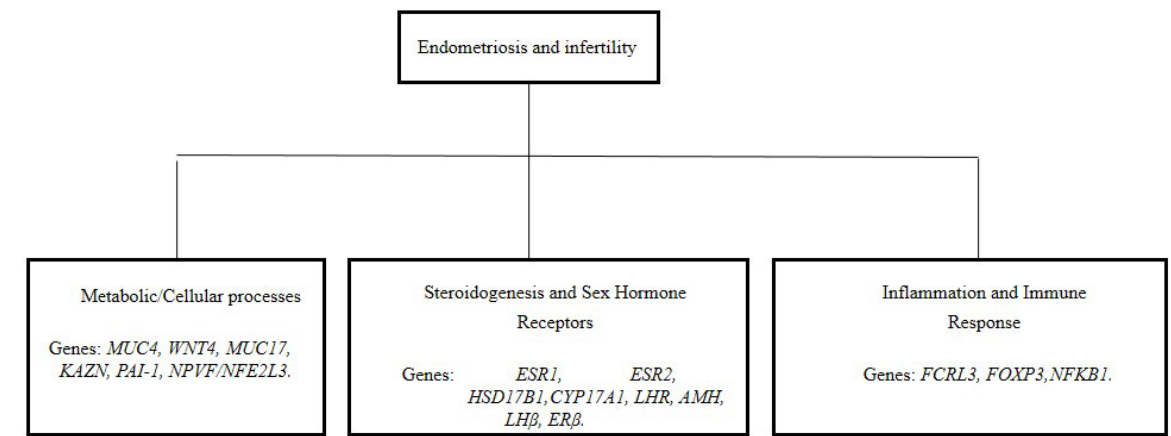
Figure 3. Classification of gene functions with statistically significant